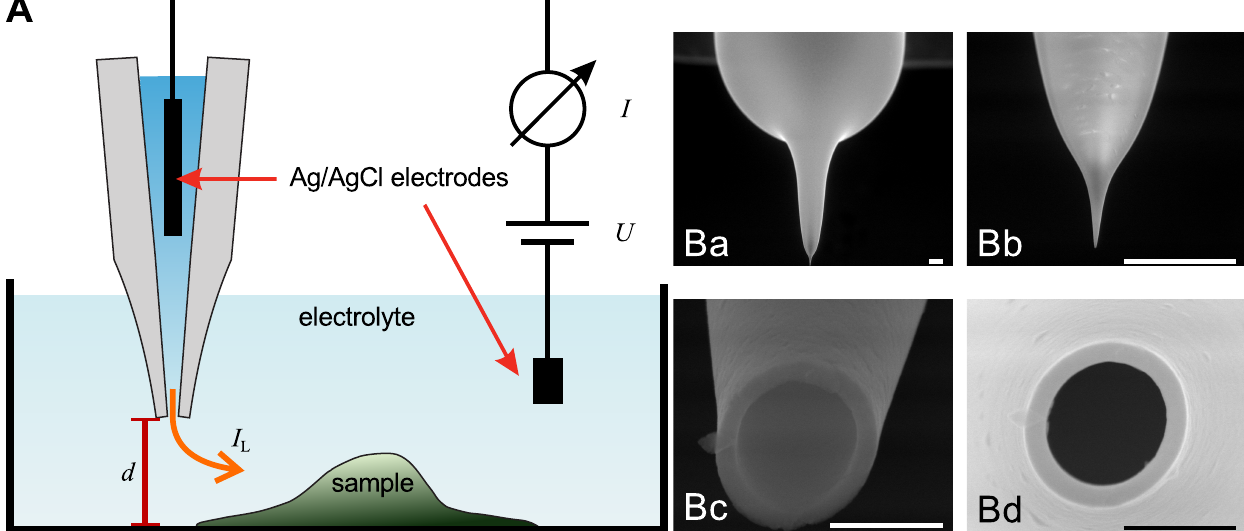
Figure 1. ( A ) Schematic illustration of the setup of a SICM. A voltage is applied between two Ag/AgCl-electrodes, one of which is located within the scanning pipette (gray). The two electrodes are connected via an electrolyte solution. The ionic leakage current I the tiny opening of the pipette depends on the distance d between pipette and sample; ( B ) Scanning electron micrographs of a scanning pipette. Scale bars: 100 µ m (Ba,